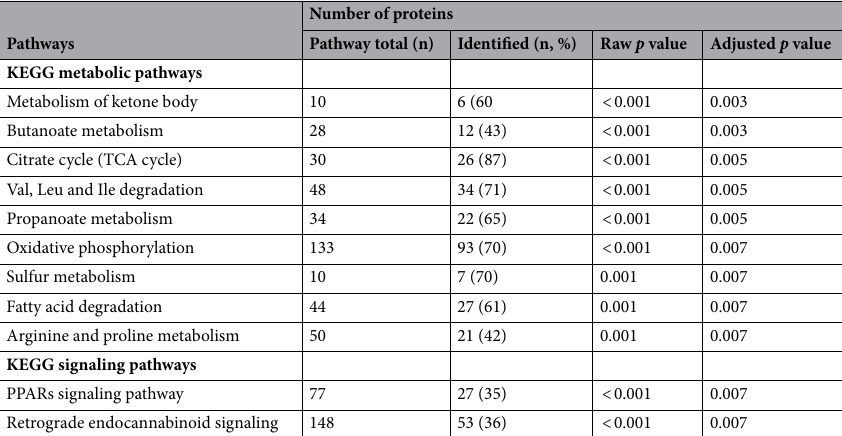
Table 2. Enrichment analysis displaying Kyoto encyclopedia of genes and genomes (KEGG) pathways. This enrichment analysis used the covariance analysis global test on the KEGG pathways database. Missing values were imputed using the probabilistic minimum imputation method. The pathways that are not considered differentially abundant (adjusted p value > 0.01) are not shown. Ile, Isoleucine; Leu, Leucine; Val, Valine; TCA, Tricyclic acid; PPARs, Peroxisome proliferator-activated